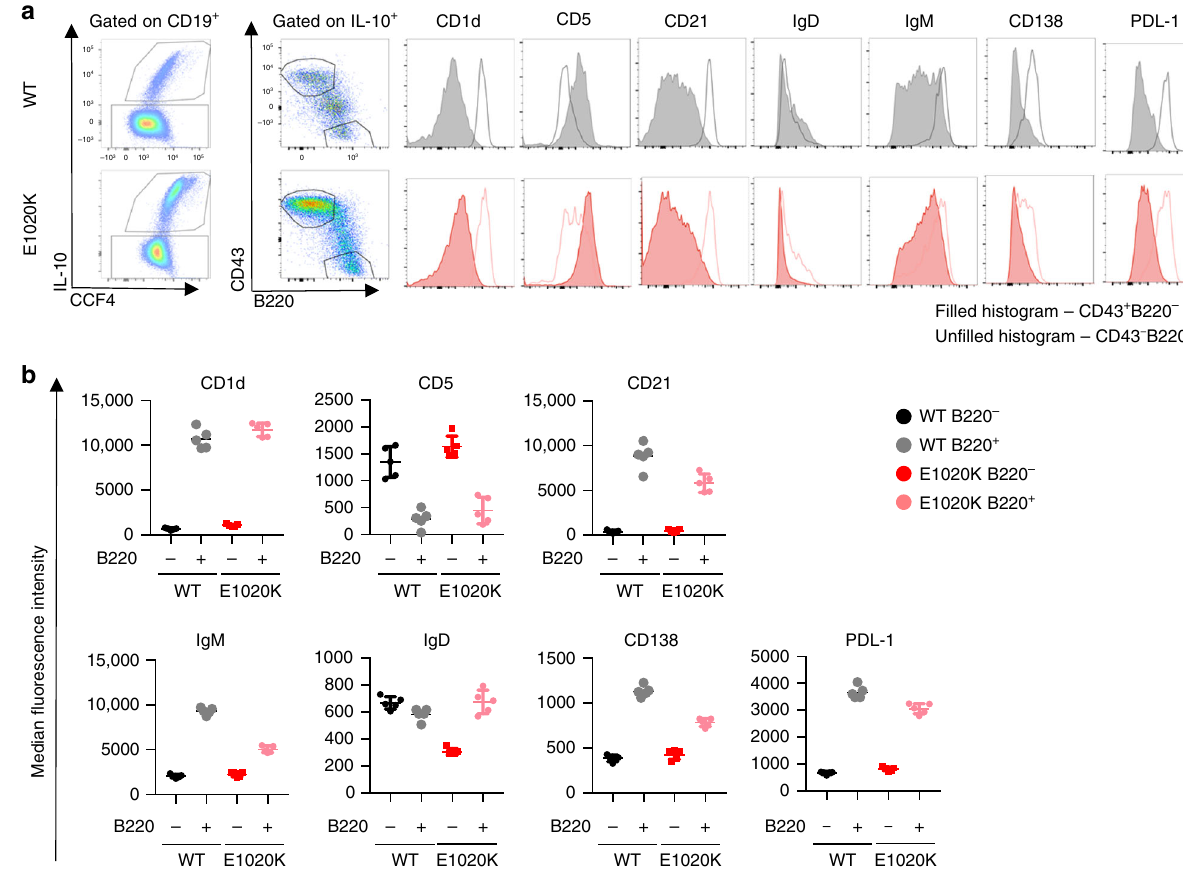
Fig. 9 IL-10 producing B220 − B cell subset is a novel B cell subset, expanded in PI3K δ E1020K mice. In order to compare surface marker expression from B220 − and B220 + IL-10 producing B cells, splenocytes from Il10 ITIB mice (WT and p110 δ E1020K ) were stimulated with LPS/PdBu/Ionomycin/Brefeldin A for 5 h and then stained for cell surface markers as shown. a After gating on IL-10 producing B cells, CD43 ++ B220 − cells were compared to CD43 − B220 + cells. Histograms highlighting the differential surface marker expression as measured by median fl uorescence intensity (MFI) between these populations are shown. b Comparison of surface marker MFI show that CD19 + B220 − IL-10 + B cells express: CD43 ++ CD5 int/ + CD23 − CD21 − CD1d lo/int IgM + /- IgD lo/- PDL1 − CD138 − as opposed to conventional Bregs expressing: CD19 hi B220 hi IL-10 + CD43 − CD5 Var CD23 − CD21 ++ CD1d hi IgM hi IgD Var/lo PDL1 + CD138 int . (mean MFI ± SD is shown, representative data from two independent experiments, n = 5; data-points represent individual